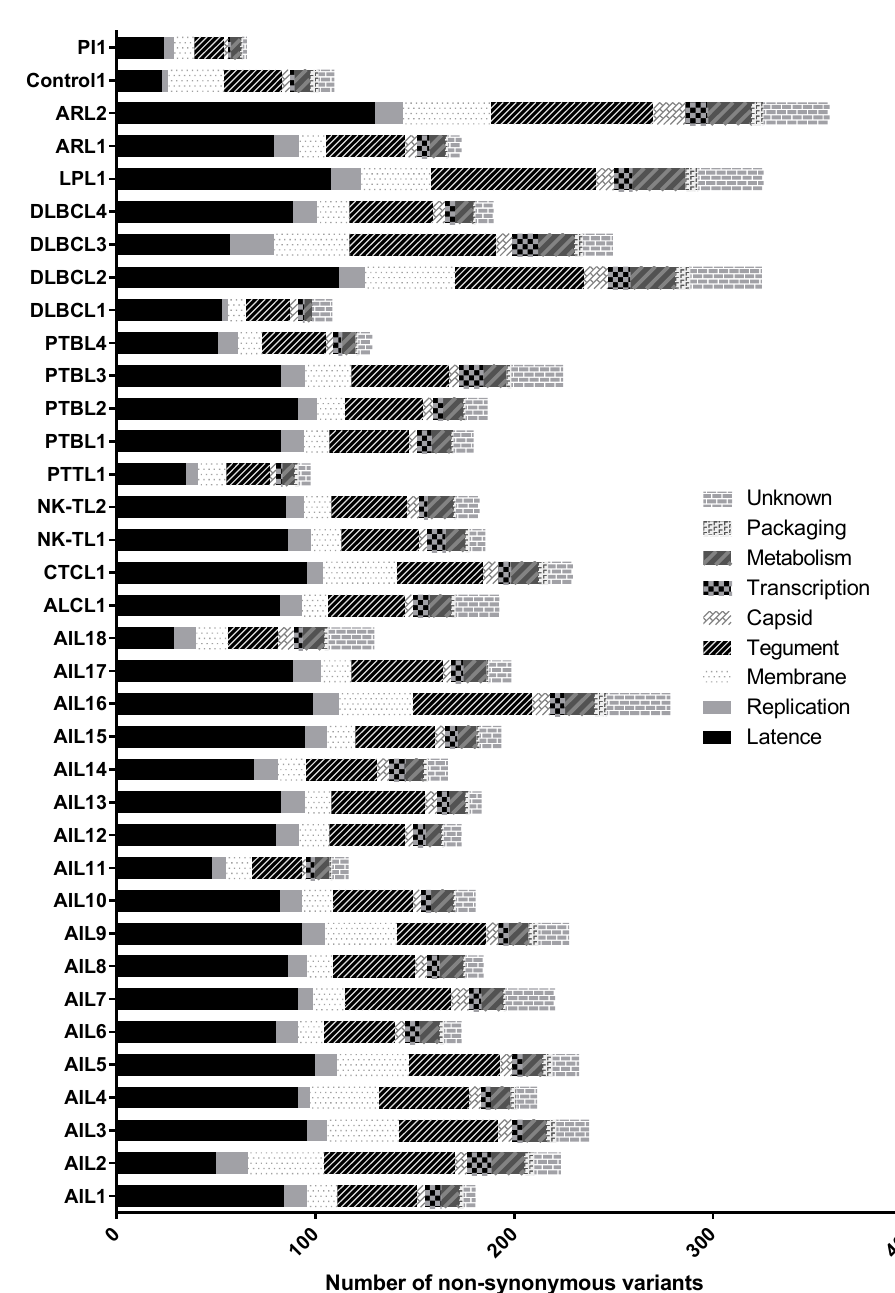
Figure 7. EBV non-synonymous mutation analysis according to nine main gene categories: latency, replication, membrane glycoprotein, tegument, capsid, transcription, metabolism, packaging, and unknown function.